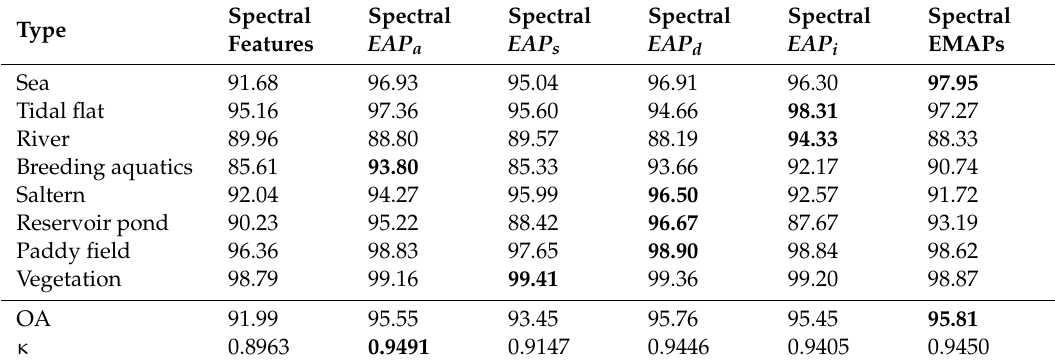
Table 6. Classification accuracy obtained by using spectral and di ff erent spectral–spatial features (Yellow River Delta (YRD)